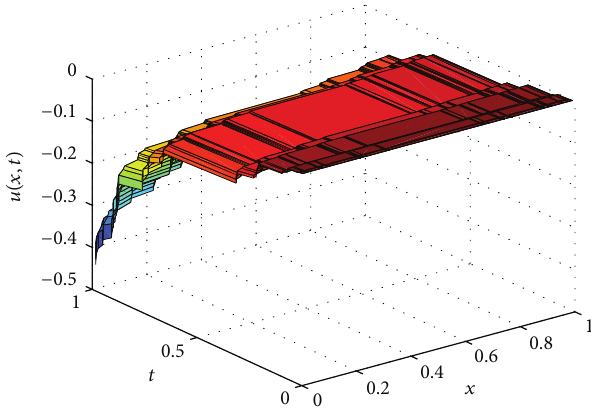
Figure 2: The solution of (1) with initial-boundary value (30) when 𝑎 = 1 and 𝛼 = ln 2/ ln 3